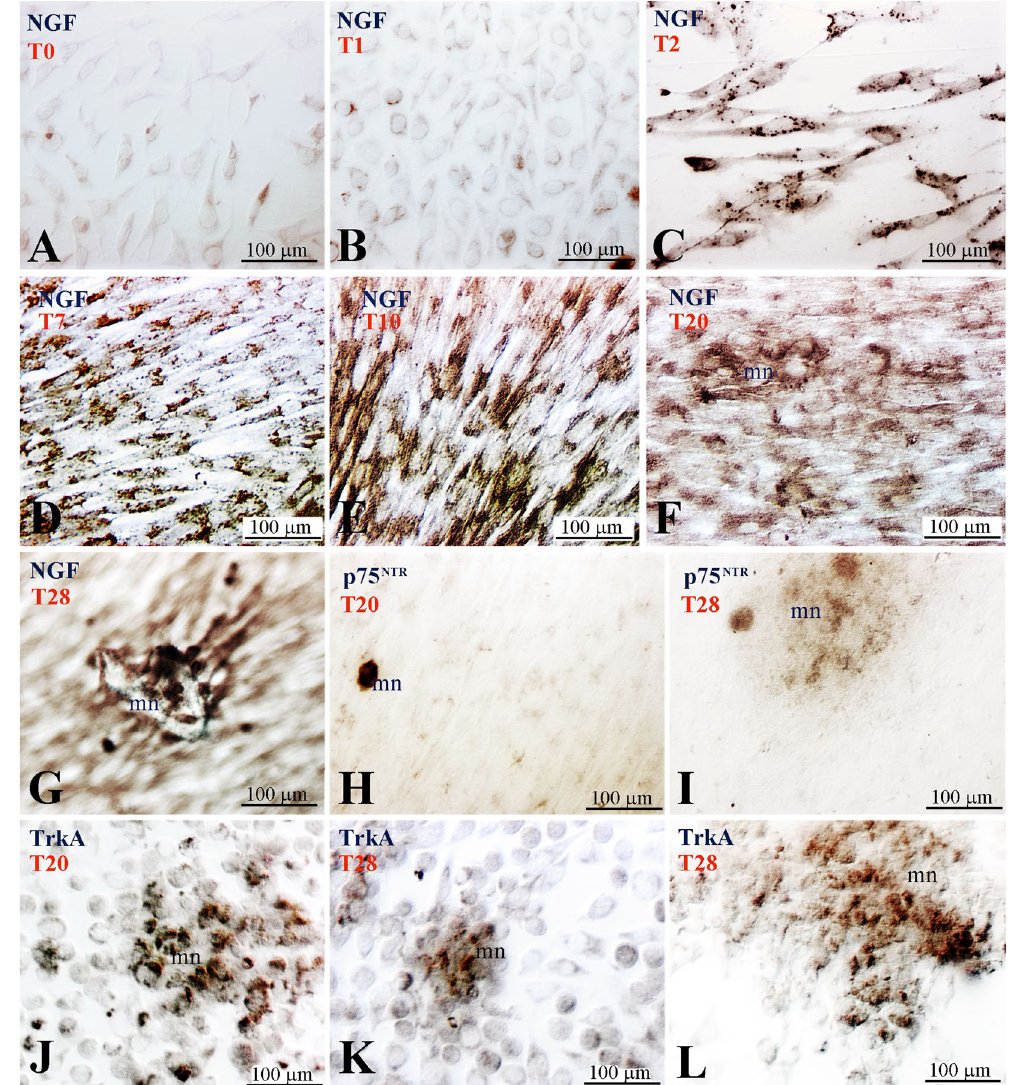
Figure 5. Expression of NGF and p75 NTR in human pulp cells cultured in the presence of β -glycerophosphate. ( A ) NGF expression at time 0 (T0). ( B – G ) NGF expression cultured in mineralizing conditions at successive time points (T1–T28). ( H , I ) p75 NTR expression in cells forming a mineral nodule (T20–T28). ( J – L ) TrkA expression in cells forming the mineral nodules (T20–T28). Abbreviation: mn, mineralized nodule; T1, one day of